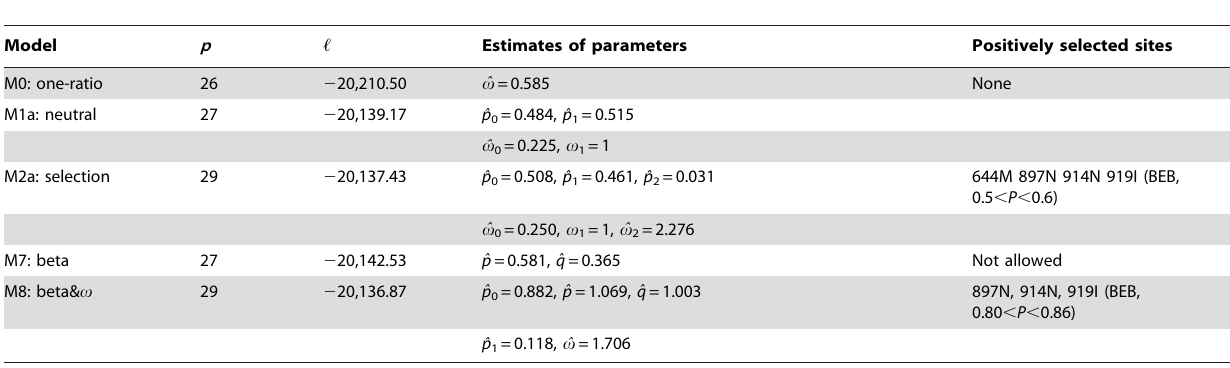
Table 2. Log-likelihood values and parameter estimates under site models for the nine mammalian BRCA1 genes.